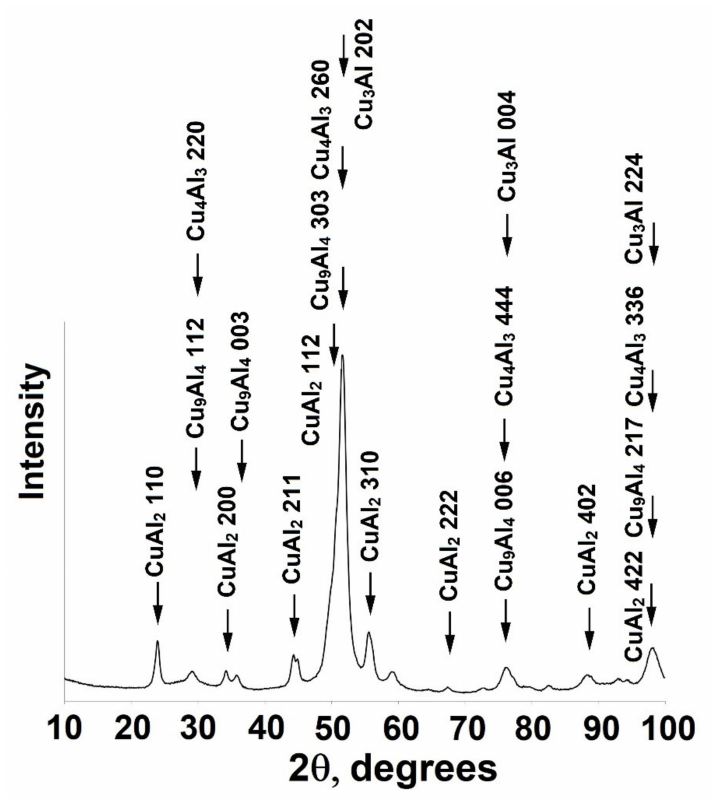
Figure 3. X-ray diffraction patterns from the composite with the matrix from Al and Cu with nanodiamond reinforcements; as shown by the